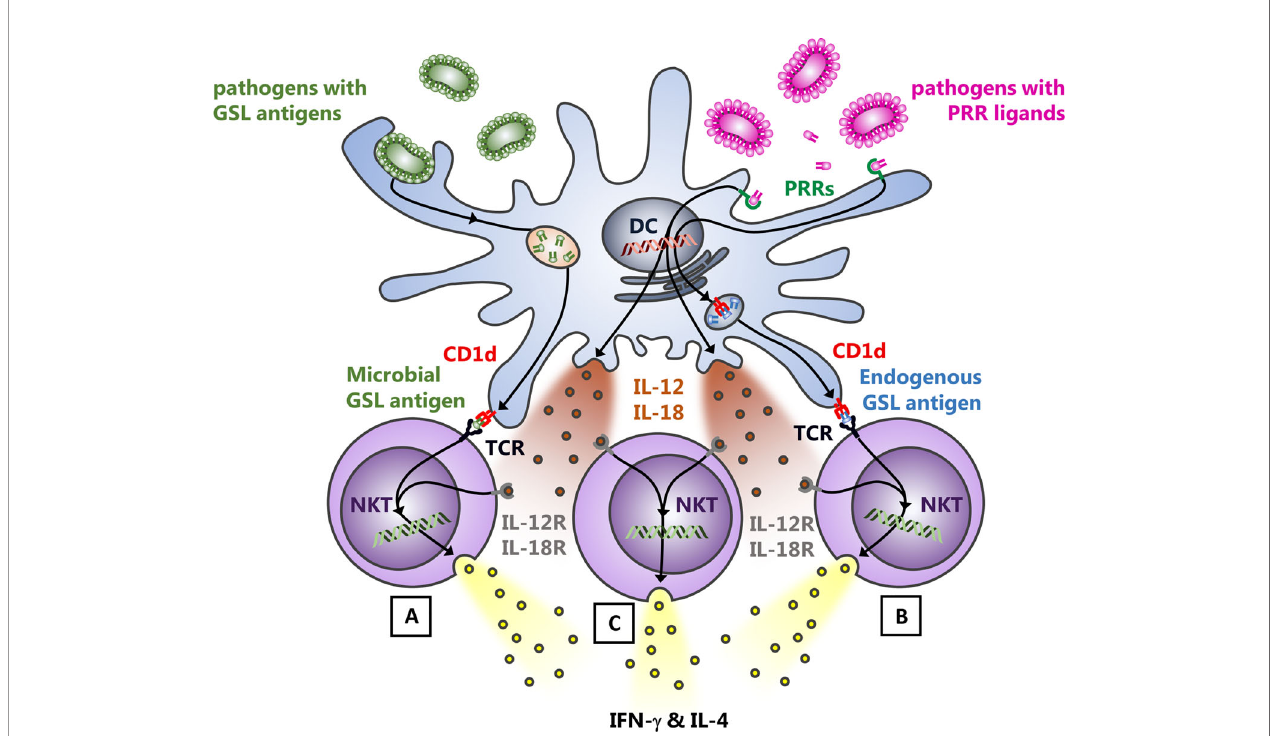
FIGURE 1 | Modes of NKT cell activation upon bacterial infection. Following the uptake and digestion of bacteria by myeloid cells, three mechanisms predominantly drive the activation of NKT cells: (A) , bacterial cell wall glycosphingolipid (GSL) antigens presented by APCs are suf fi cient to induce the release of IFN- g and IL-4 by NKT cells due to the CD1d mediated presentation of the ligand to the NKT cell TCR. (B) , endogenous GSL presentation via CD1d to the NKT cell TCR in response to infection and subsequent augmented NKT cell auto-reactivity. The identity of the lipid ligands underlying the auto-reactivity of NKT cells in different tissues and under distinct (patho-) physiological circumstances, however, still requires de fi nition. (C) , the cytokine driven, TCR-independent activation of NKT cells for which TLR- oder Dectin triggered IL-12 and IL-18 release by APCs is responsible. This also further enhances the release of cytokines by NKT cells, activated by cognate TCR engagement [mechanisms (A, B) ]. Thus, NKT cells are activated during infection with bacteria that do not express themselves NKT cell antigens in their cell walls or unable to induce endogenous